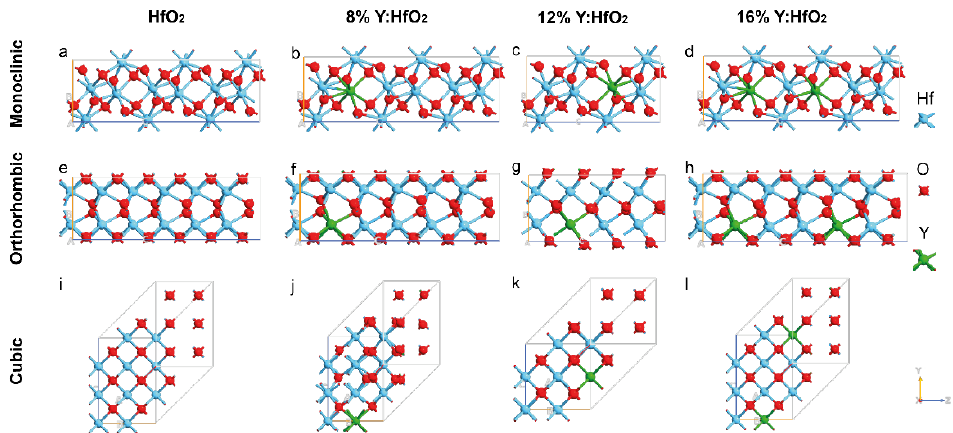
Figure 1. Schematic representation of all the examined systems. Monoclinic P21/c ( a ) HfO 2 , ( b ) 8% Y:HfO 2 , ( c ) 12% Y:HfO 2 , and ( d ) 16% Y:HfO 2 ; Orthorhombic Pca21 ( e ) HfO 2 , ( f ) 8% Y:HfO 2 , ( g ) 12% Y:HfO 2 , and ( h ) 16% Y:HfO 2 ; Cubic Fm3 ̅ m ( i ) HfO 2 , ( j ) 8% Y:HfO 2 , ( k ) 12% Y:HfO 2 , and ( l ) 16% Y:HfO 2 . Color code in the ball and stick model: Y green, Hf blue and O red.